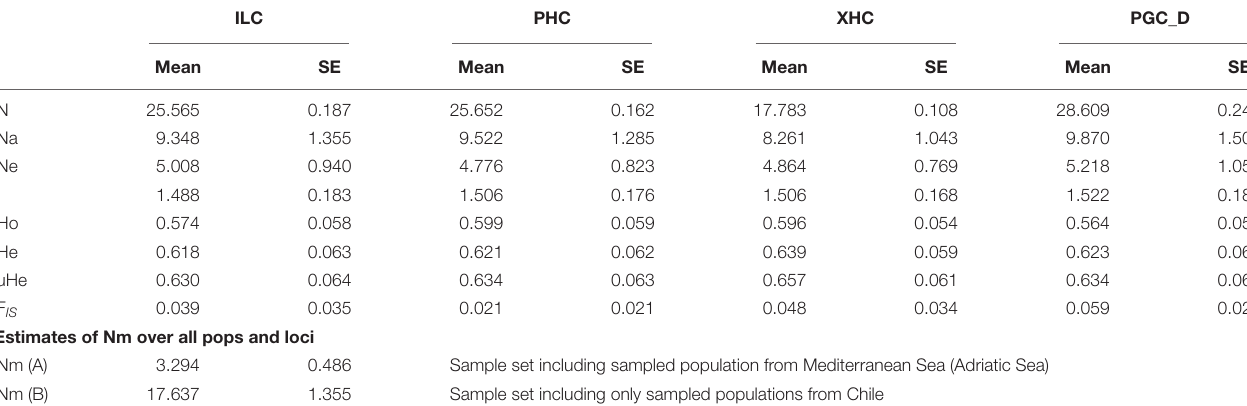
TABLE 1 | Genetic variability and diversity by sampling locations of Desmophyllum dianthus in Comau Fjord.